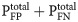
Consensus-based clustering applied to in vivo MEA recordings with artificial ground truth spikes.a. Eight artificial spike trains were added to the raw voltage signal recorded with a 32-channel linear electrode array in the dorsal cortex of the anaesthetized turtle during visual stimulation (see Methods). The artificial spikes waveforms were generated from the cluster template of single units recorded simultaneously but from another electrode array. Artificial spikes were randomly varied in amplitude by ± 10% standard deviation to mimic realistic spike shape variability. b. Left, dendrogram obtained by hierarchical clustering with the Single-Link method over the distance matrix defined from the pairwise probability of spike misclassification between the final clusters (Pmis, see Methods). Right, Pairwise probability of spike misclassification between final clusters. c. Whitened spatiotemporal waveforms of 6 of the final clusters identified by consensus-based clustering. The cluster templates were defined as the average waveform (black). Cluster #1 and #63 were identified as matching the ground truth spikes of cell #4, and #2 respectively. The estimated probability of misclassified spikes (PFPtotal+PFNtotal, see Methods) is shown below each cluster, as well as the true rate of misclassification (color).